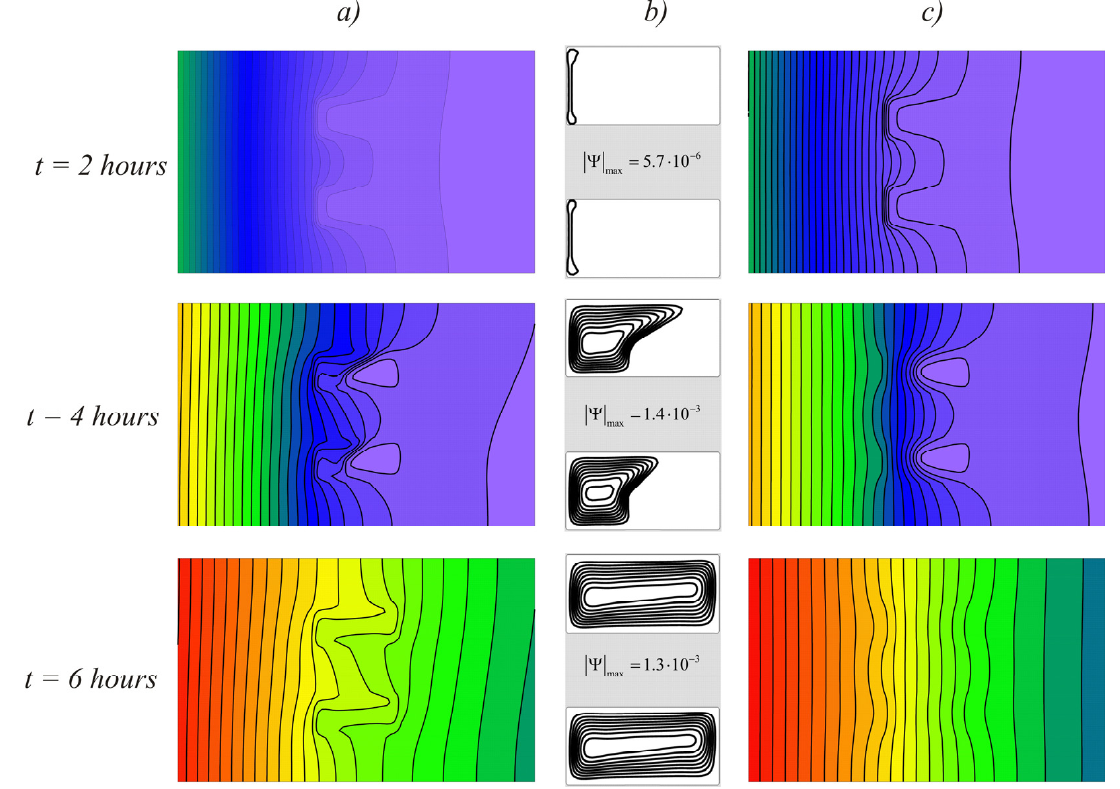
Figure 6. Temperature fields ( a ) and streamlines ( b ) for the case L = 0.01 m and ∆ T = 20° taking into account natural convection in the melt and temperature distributions obtained without natural convection ( c ) at different times.